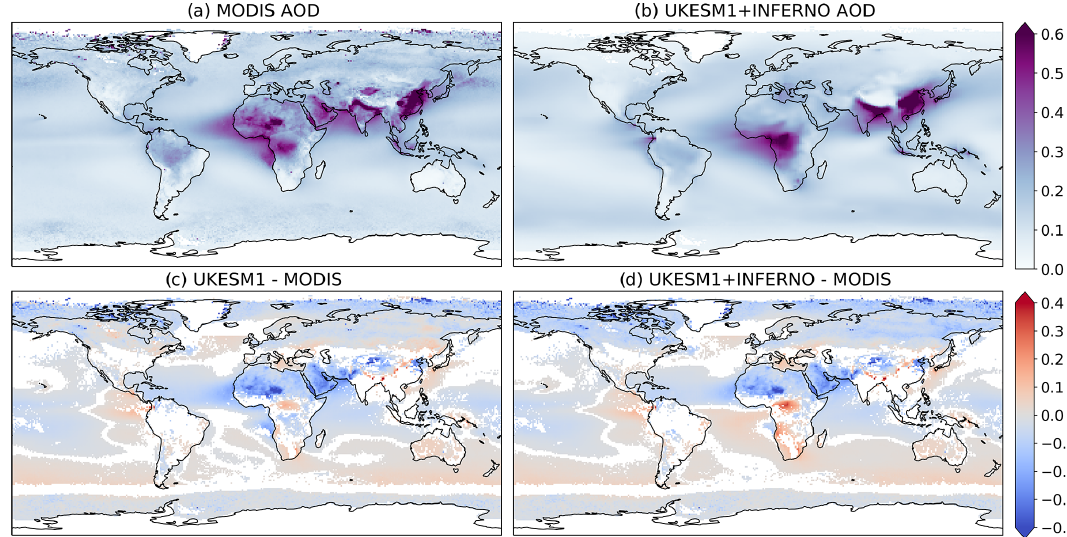
Figure 11. Aerosol optical depth multi-year average annual mean at 550nm (2003–2012) for (a) MODIS, (b) UKESM1+INFERNO, (c) difference between UKESM1 and MODIS, and (d) difference between UKESM1+INFERNO and MODIS. Differences are only shown for statistically significant points with a 95% confidence